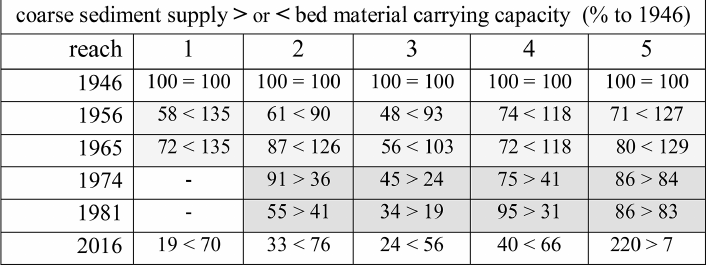
The underlined values in Table 5 (with reservoirs) are used; symbols a , b and c in Table 5 apply here too. Dark grey boxes mean likely aggradation ( > ) and light grey likely degradation ( < ). Table 7. Coarse sediment transport ( × 10 3 m 3 /yr). The quantities at the right-hand side of symbols > or < are capacities from Table 5 (with reservoirs); those at the left-hand side are supplies transferred.